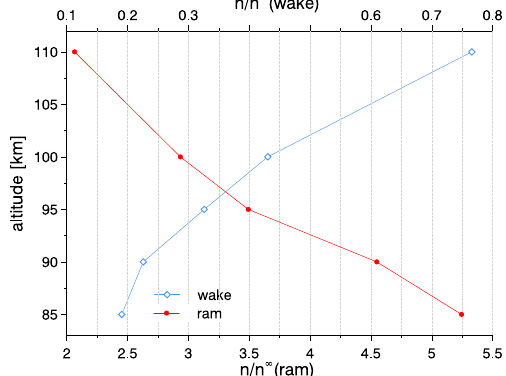
Figure 10. Ratios between local and free-stream total number den- sity at the sensor position as a function of altitude. The ratios are obtained from numerical simulations made at the marked altitudes and are used as aerodynamic correction factors.